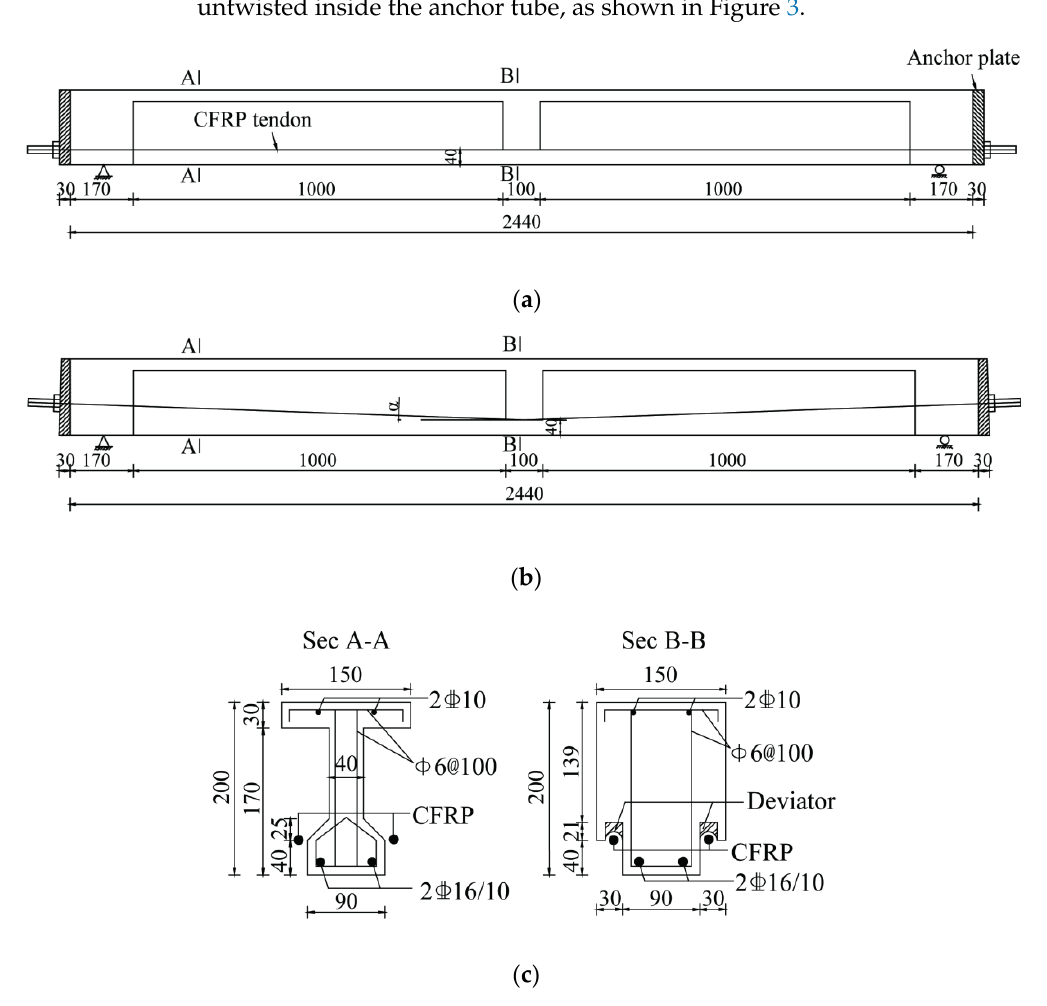
Figure 1. Dimensions and cross section of specimens (dimensions in mm): ( a ) layout of specimens with horizontal tendons; ( b ) layout of specimens with deviated tendons; ( c ) details of section A-A and B-B for partially prestressed beams.